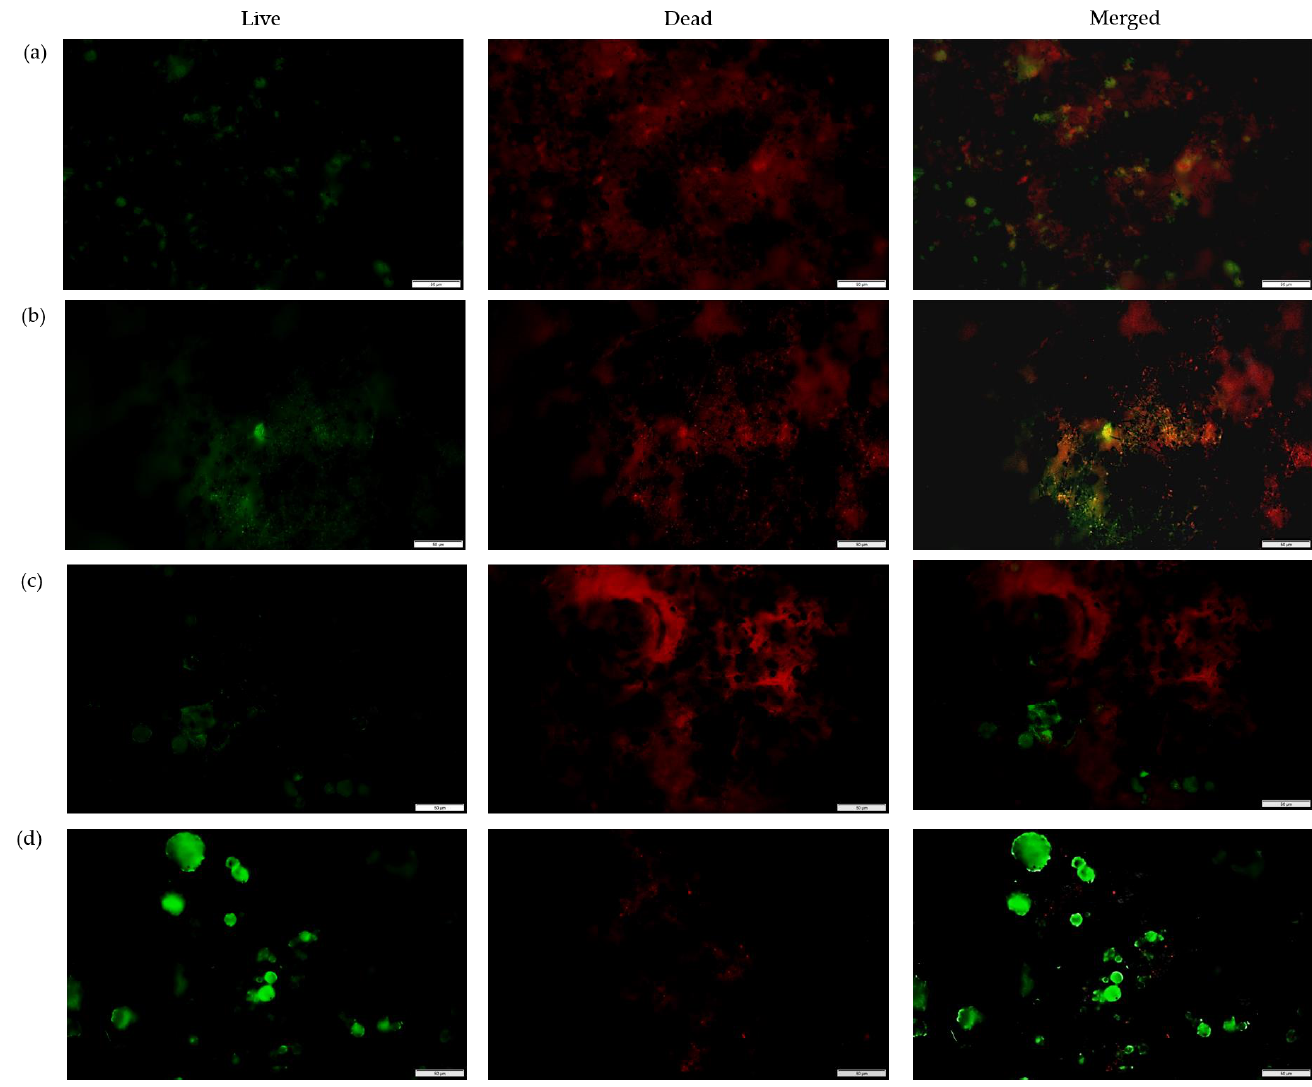
Figure 9. Fluorescence microscopy images of S. aureus attachment on ( a ) PGO; ( b ) PGO-M1; ( c ) PGO-M2; and ( d ) PGO-M3 nanofibers at 40x magnification (scale bar: 50 µm).